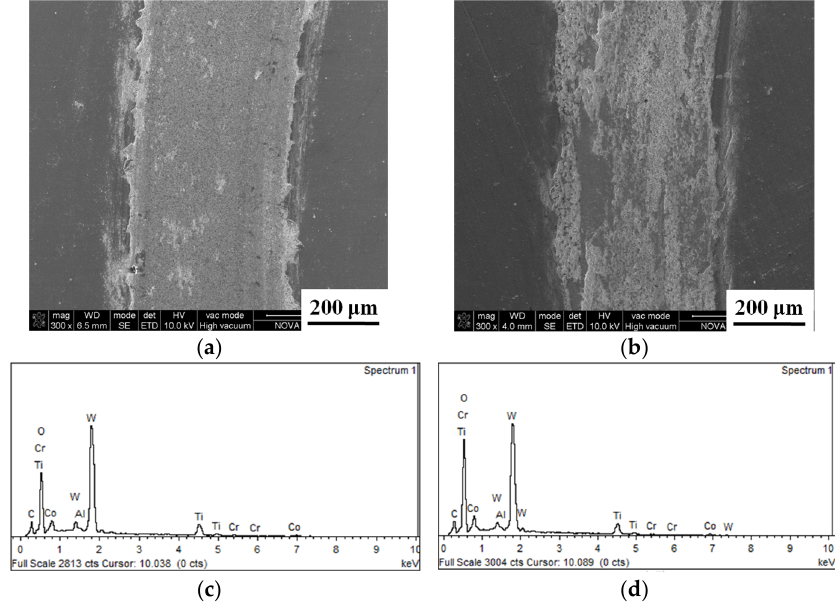
Figure 15. SEM images of wear tracks on the AlCrN coatings deposited at 550 V charge voltage after the pin ‐ on ‐ disk wear tests at ( a ) 600 °C and ( b ) 800 °C, ( c ) and ( d ) show the EDX results on the wear tracks in ( a ) and ( b ), respectively.